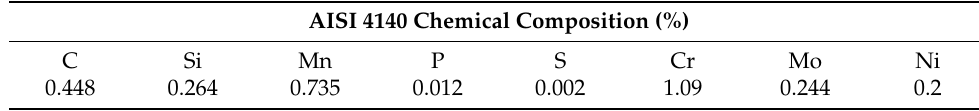
Table 2. Chemical composition of AISI 4140 (42CrMo4).